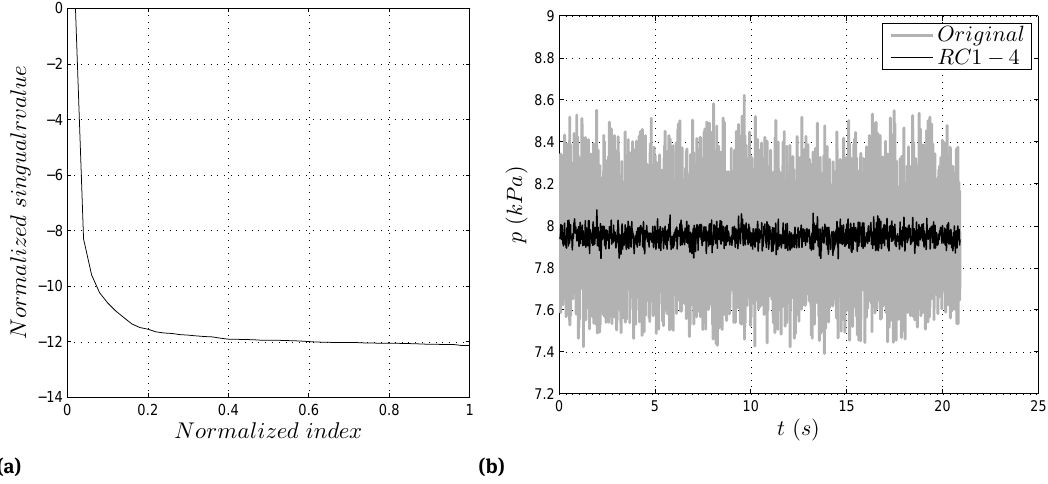
Figure 5: a) Singular value spectra and b) Source signal and sum of its three first principal components at stable working conditions (TOA = 30%) at the blower outlet